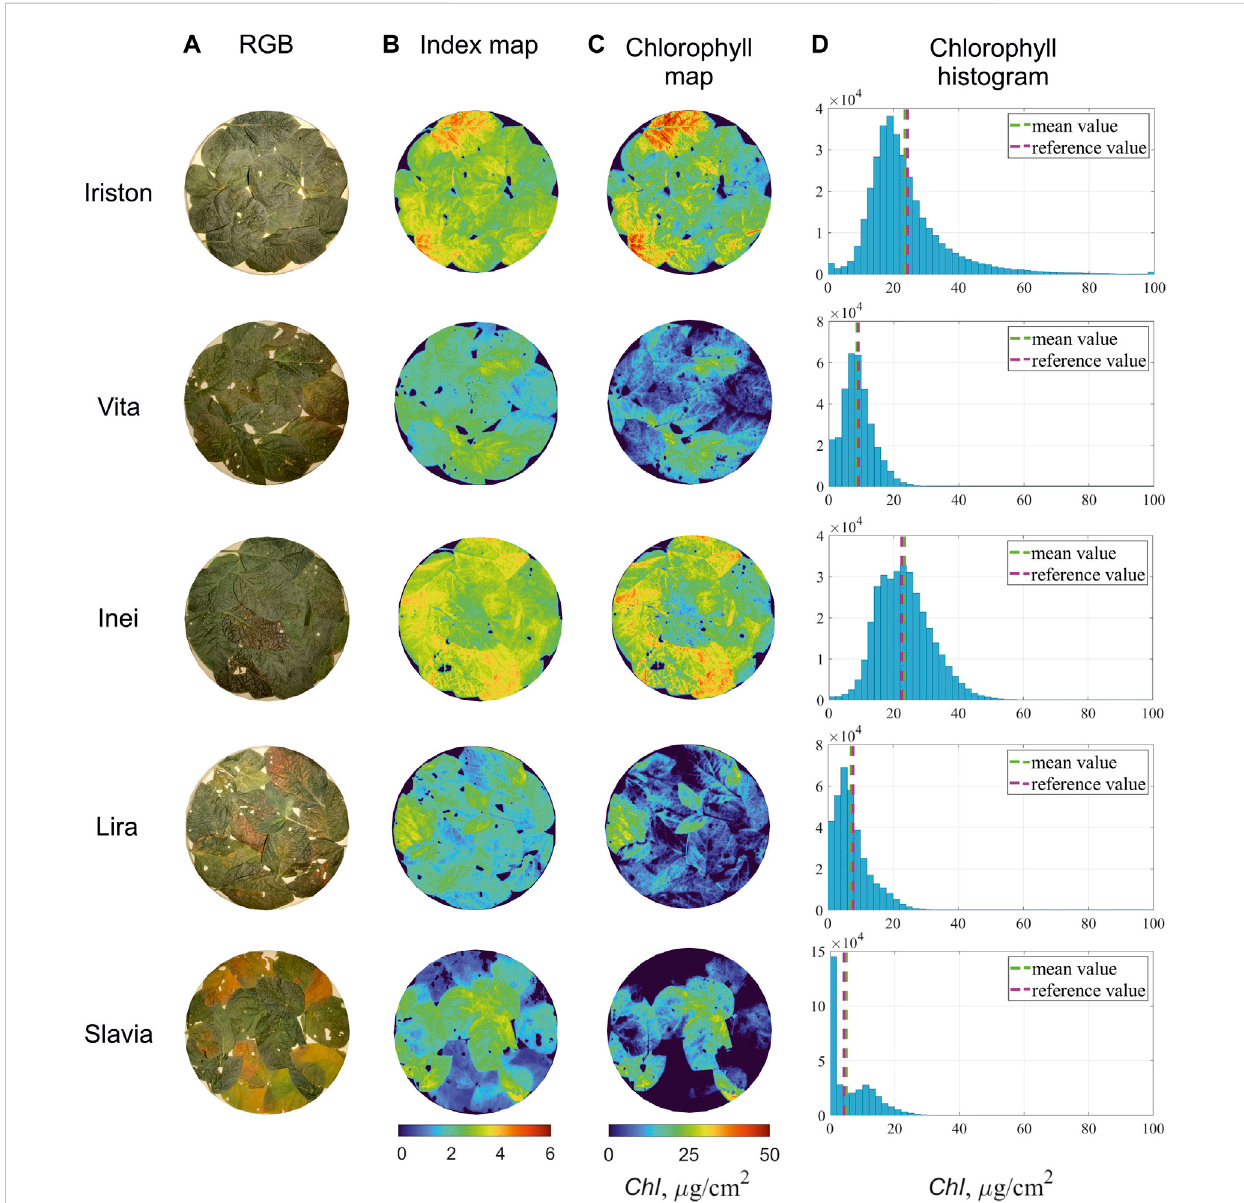
FIGURE 6 Color images of inspected soybean leaves (A) and calculated maps of the index CI RE (B) . Chlorophyll concentration distributions (C) are evaluated fromCI RE maps (B) usinglinearmodelpresentedinTable5.Chlorophyllhistograms (D) illustratefrequencydistributionsofCCvaluesin (C) andshowsthat their mean values (green dashed line) are close to the reference ones (pink dashed